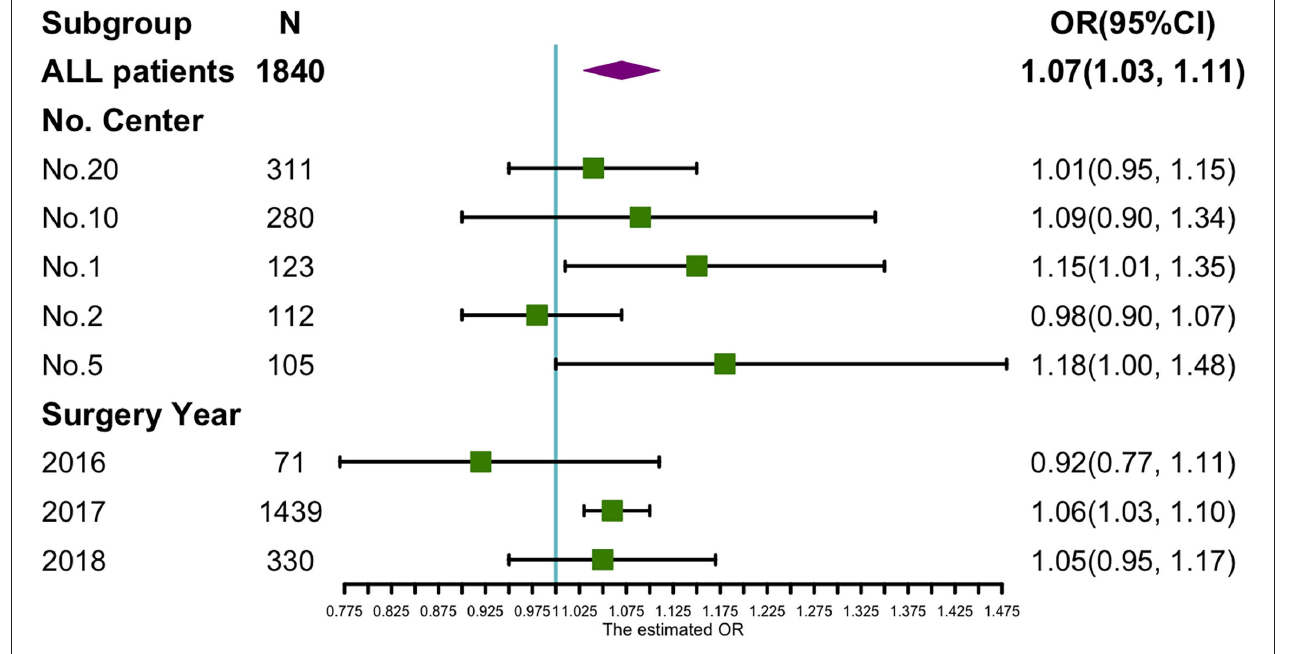
FIGURE 2 | Sensitivity analysis of incision length on PPOI incidence in subgroups of different surgery years and hospital